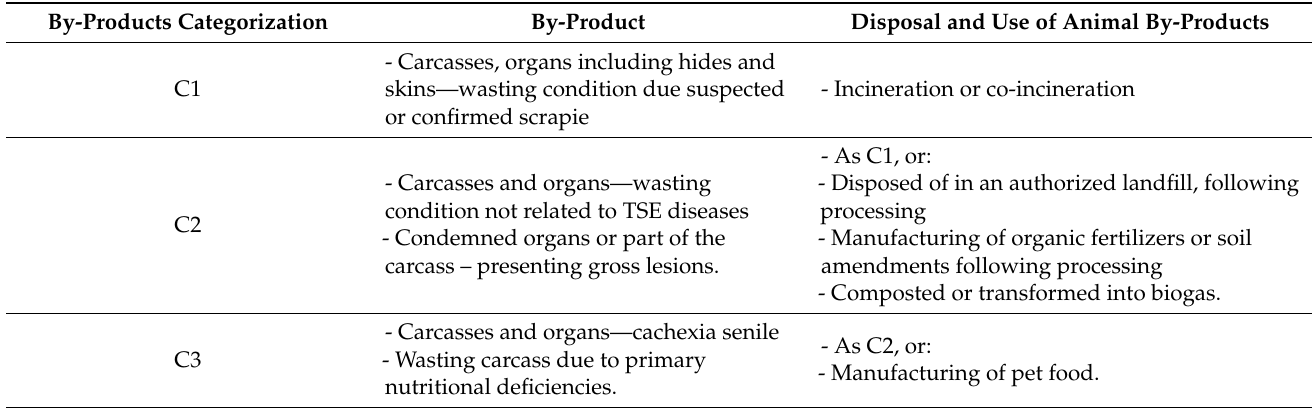
Table 5. Classification, disposal, and use of condemned wasting carcasses affected organ or part of the carcass (animal by-products), according to Regulation (EC) No 1069/2009